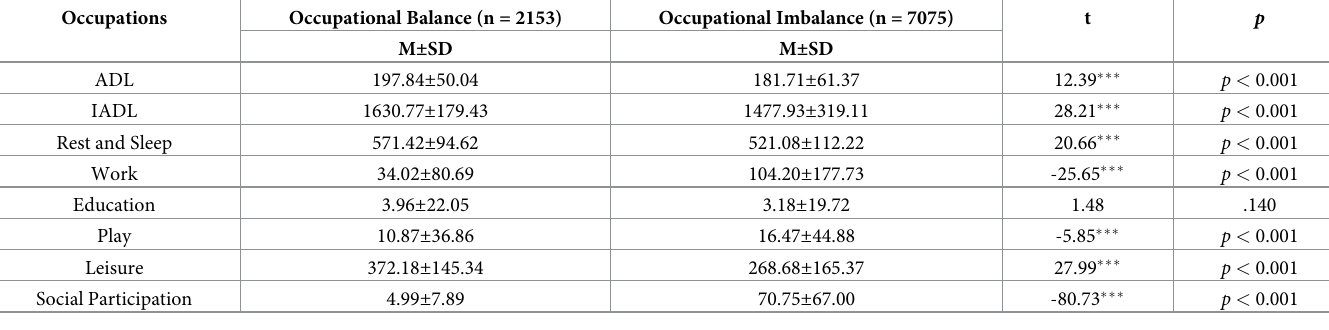
Table 2. Comparison of time- use between the occupational balance group and occupational imbalance